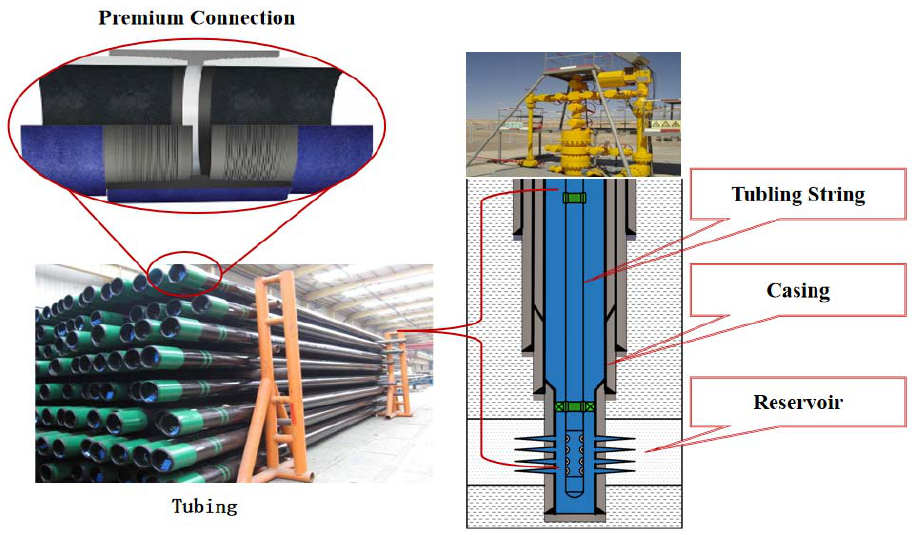
Figure 1. Schematic diagram of premium connections of a tubing string.